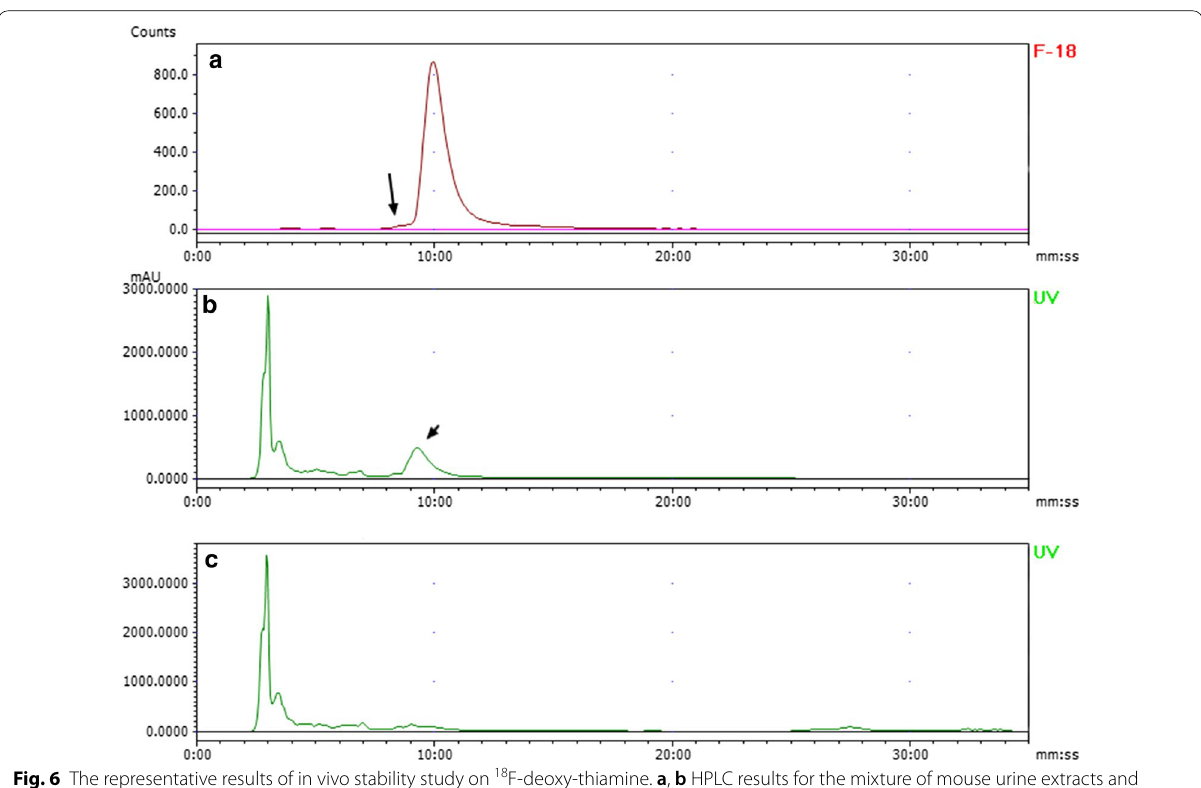
Fig. 6 The representative results of in vivo stability study on 18 F-deoxy-thiamine. a , b HPLC results for the mixture of mouse urine extracts and cold standard sample of 18 F-deoxy-thiamine. a The radio-signal, and the retention time of 18 F-deoxy-thiamine was 9 min 54 s. Note that the unknown metabolite(s) was ahead of 18 F-deoxy-thiamine (arrow). b The UV-signal, and the retention time of cold standard sample was 9 min 14 s (arrowhead). The UV-signal acquisition system was ahead of radio-signal, and the time-lag was about half-minute. c The UV signal of analyzing only the mouse urine extracts. UV 254 nm. The peak around 3 min in b , c was the metabolic compounds excreted through kidney into urine. Although = the urine was treated by deproteinization, centrifugation, and filtration, many in-vivo metabolic compounds could not be separated and